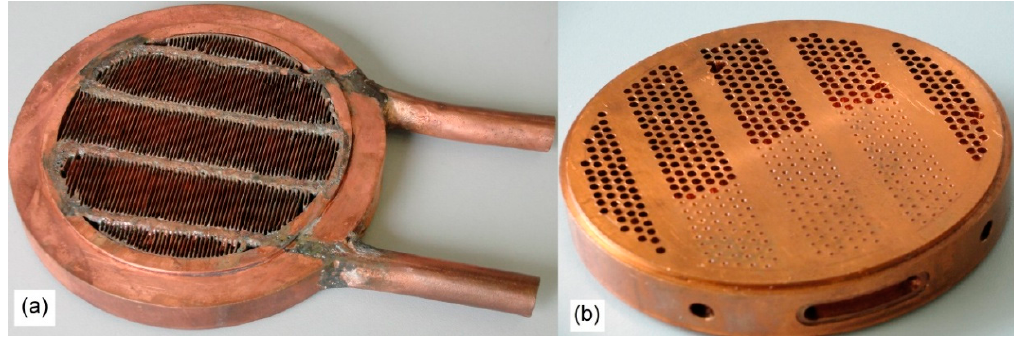
Figure 4. ( a ) The ambient heat exchanger with rectangular pore geometry; ( b ) The ambient heat exchanger with circular pore geometry.